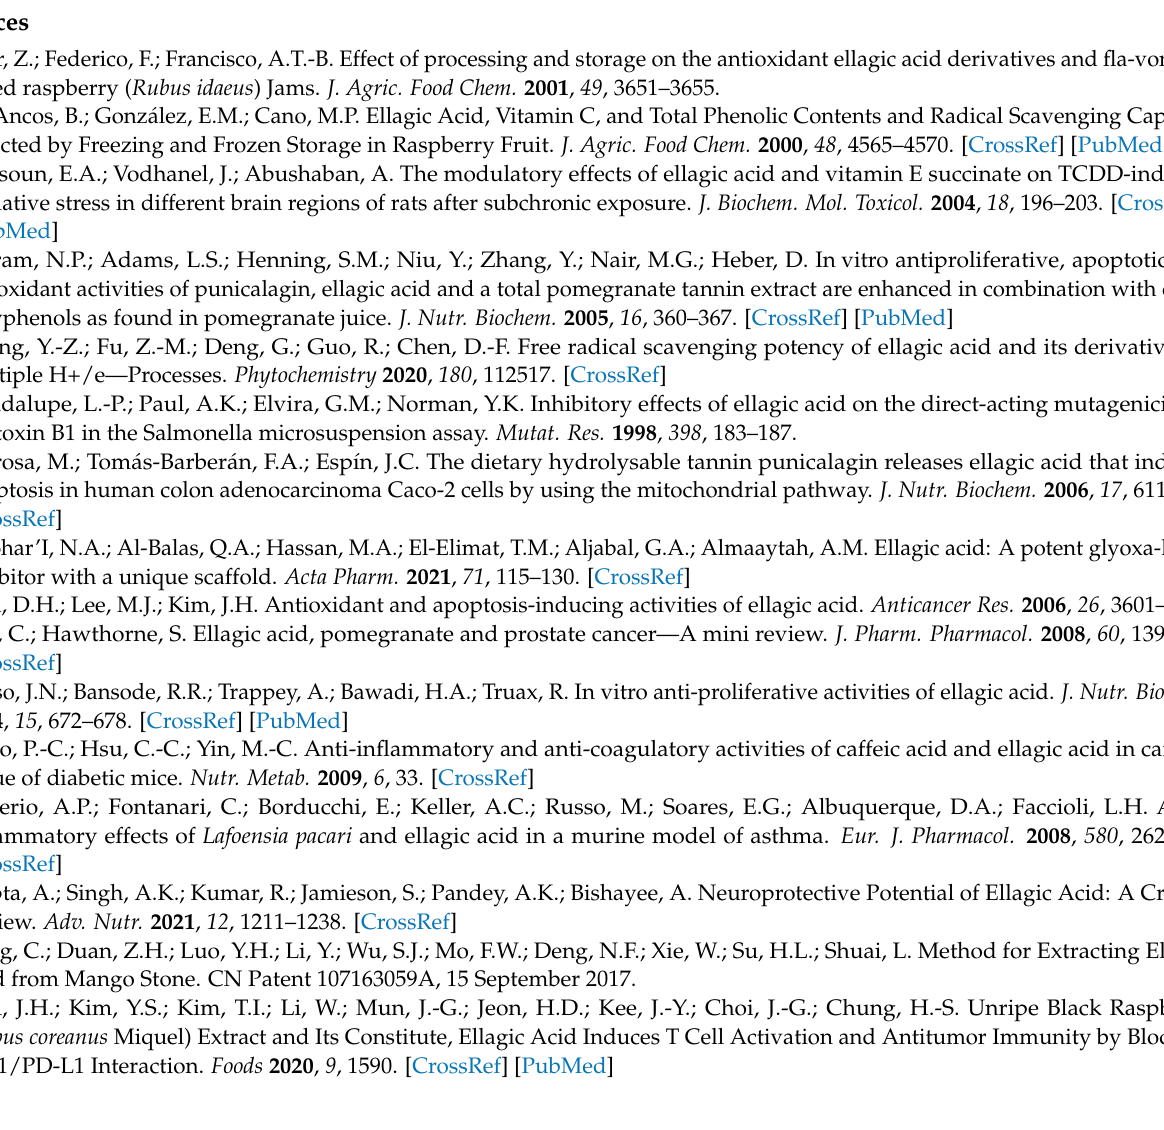
C NMR spectrum of ellagic acid. Figure S3: The MS spectrum of ellagic acid. Figure S4: UPLC chromatogram of ellagic acid. Table S1: Calibration curves, linear ranges, LODs, LOQs, precision, repeatability, stability and recovery of 5 standards